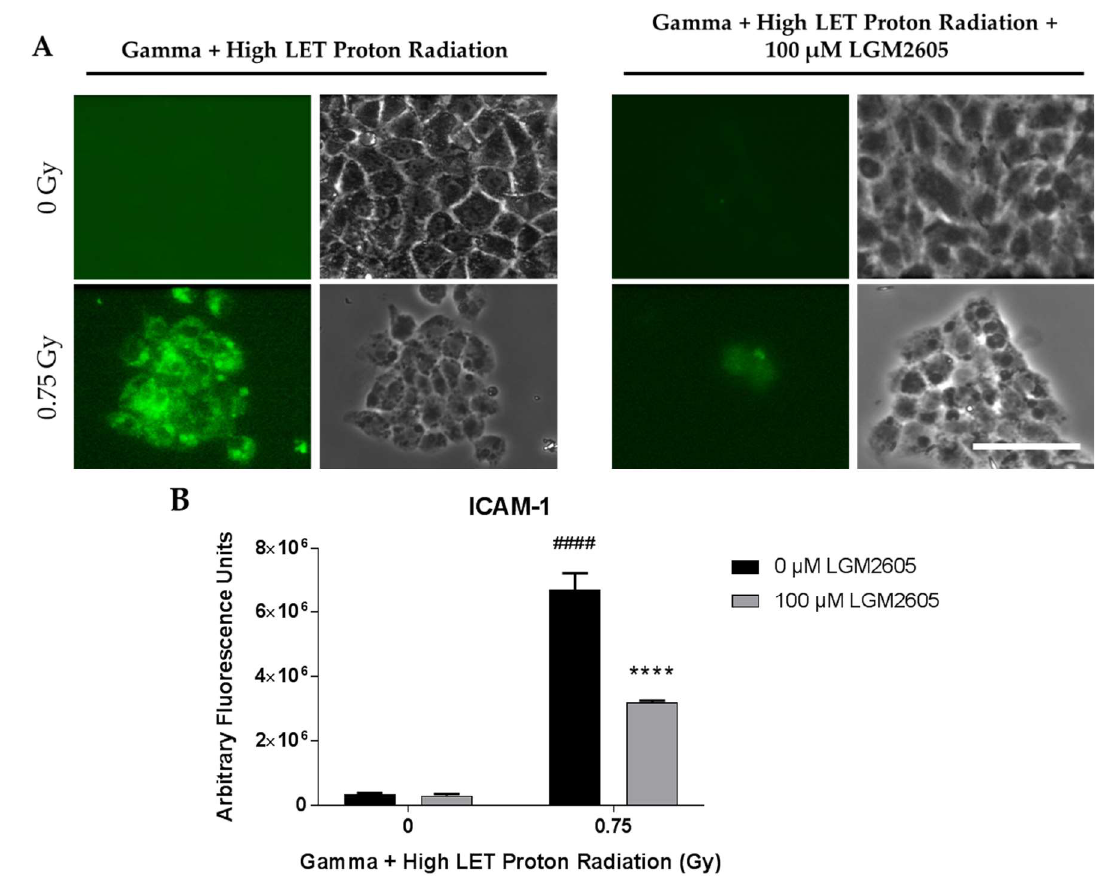
Figure 9. Evaluation of LGM2605 inhibition of ICAM-1 activation in in vitro lung vascular networks (flow-adapted endothelial cells) exposed to mixed field gamma and proton radiation. FAECs were exposed to 0 Gy or 0.25 Gy gamma radiation and subsequently exposed to 0 Gy or 0.5 Gy high LET (8–10 keV/ µ m) proton radiation. FAECs were treated with 0 µ M or 100 µ M LGM2605 30 min following gamma radiation exposure. Cells were harvested 24 h post radiation exposure and evaluated for ICAM-1 expression. Fluorescent images of FAECs exposed to LGM2605 (0 µ M or 100 µ M) 30 min following radiation exposure and harvested at 24 h radiation exposure and incubated with anti-ICAM-1 antibody (ThermoFisher Scientific, Waltham, MA, USA). Scale bar = 20 µ m ( A ); graphed representation of the data imaged for each condition ( B ). Data are presented as mean ± SEM. # shown in figures indicate significant differences from FAECs exposed to 0 Gy mixed field gamma and proton radiation and treated with 0 µ M LGM2605 (#### p < 0.0001). Asterisks shown in figures indicate significant differences from FAECs exposed to 0.75 Gy mixed field gamma and proton radiation and treated with 0 µ M LGM2605 (**** p < 0.0001).